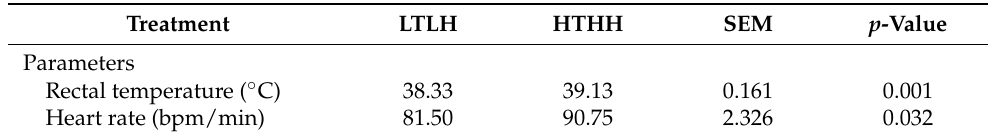
Table 3. Physiological parameters (rectal temperature and heart rate) in dairy cows exposed to two distinct environmental conditions.